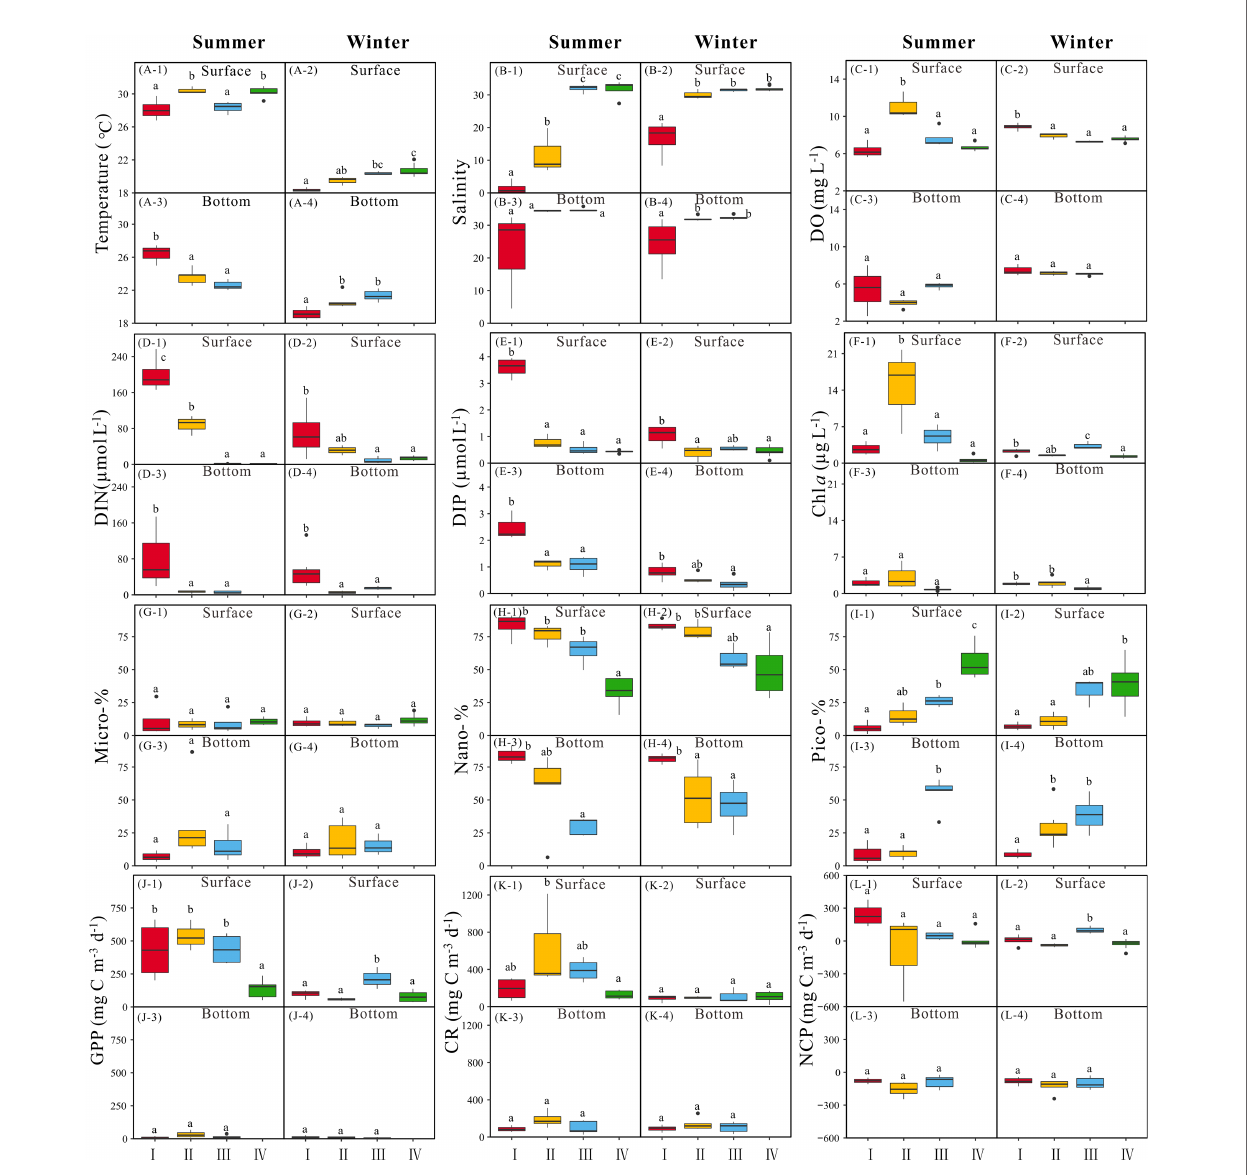
FIGURE 6 | Regional variance of temperature ( A , °C), salinity (B) , DO ( C , mg L -1 ), DIN ( D , m mol L -1 ), DIP ( E , m mol L -1 ), Chl a concentration ( F , m g L -1 ), Micro-% (G) , Nano-% (H) , Pico-% (I) , GPP ( J , mg C m -3 d -1 ), CR ( K , mg C m -3 d -1 ) and NCP ( L , mg C m -3 d -1 ) in surface (-1, -2) and bottom (-3, -4) layer along transections of the GGBA in summer (-1, -3) and winter (-2, -4) periods. Different letters in each box plot indicate the signi fi cant differences among different groups (Turkey' HSD test, p <